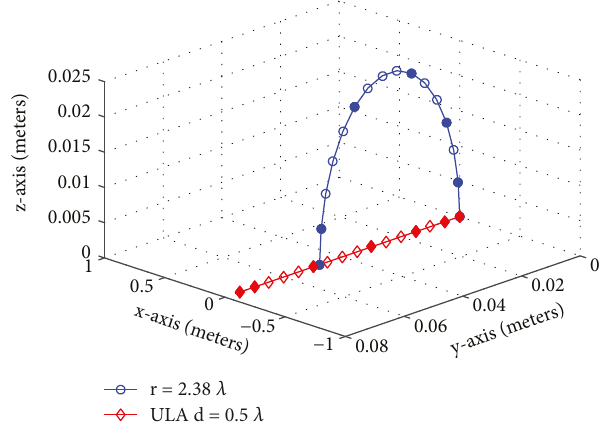
Figure 7: Element positions for the MRA (M2) in fl at and bent (in the yz -plane) positions.